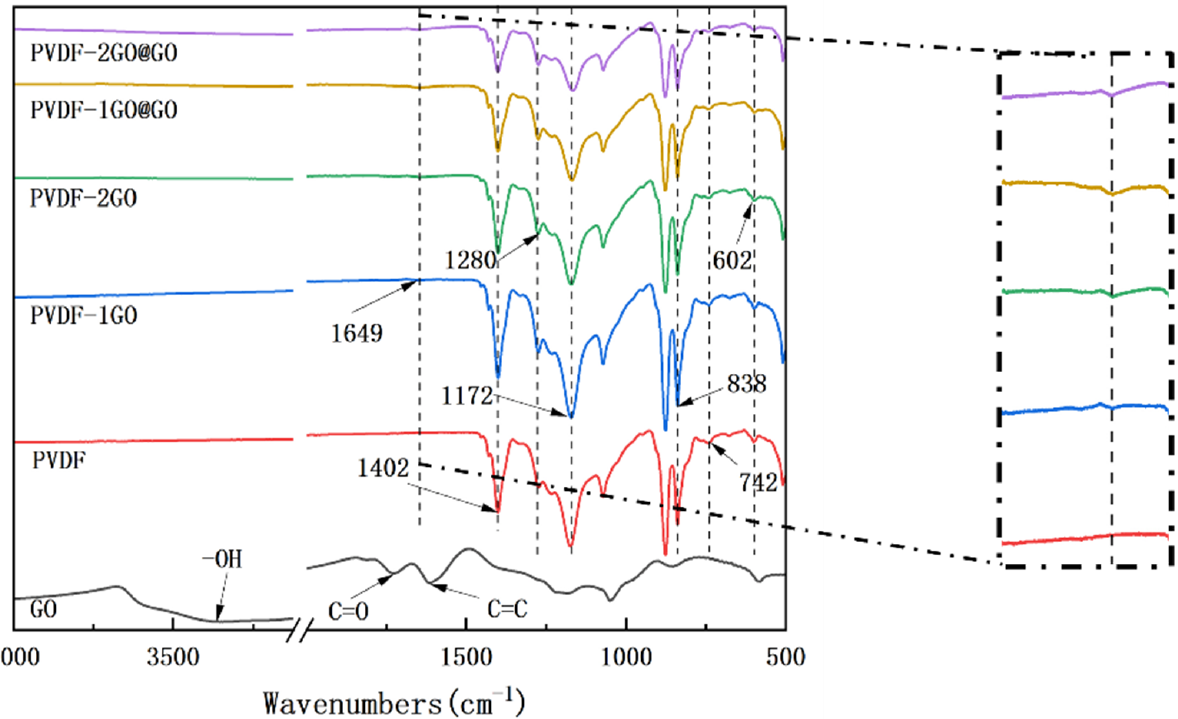
Figure 2. FTIR spectra of GO powder, PVDF, PVDF–1GO, PVDF–2GO, PVDF–1GO@GO, and PVDF–2GO@GO nanofibers.